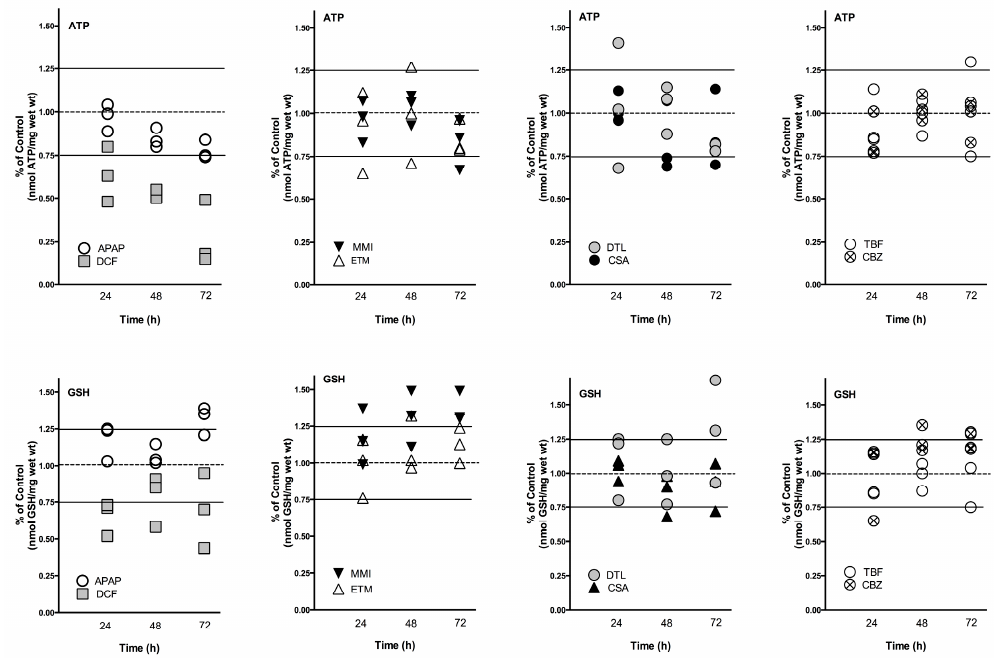
Figure 2. Human liver slice ATP and GSH mean levels are represented as percent of control (24, 48, 72 h) for the 3 individual livers to compare drug response across the livers.